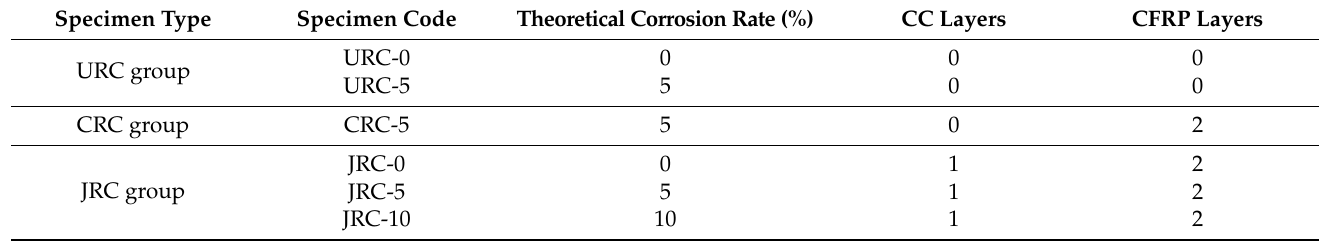
Figure 1. Specimen and reinforcement details. Table 1. Mechanical properties of the reinforcement and CFRP.